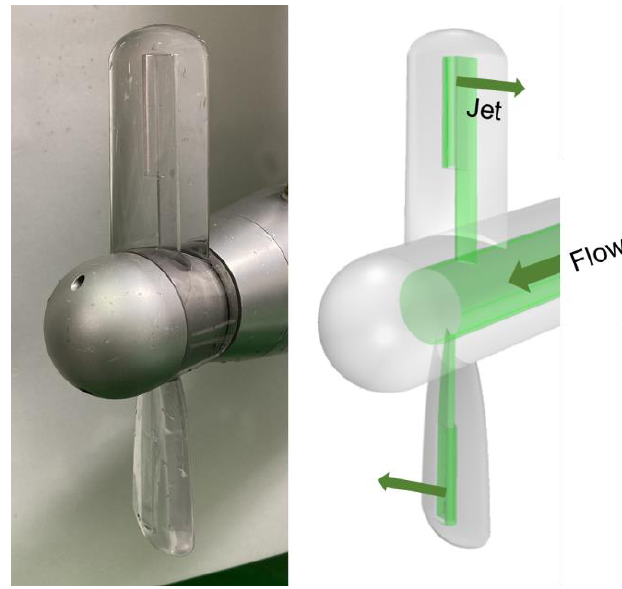
Figure 2. Propeller shape used in experiment.